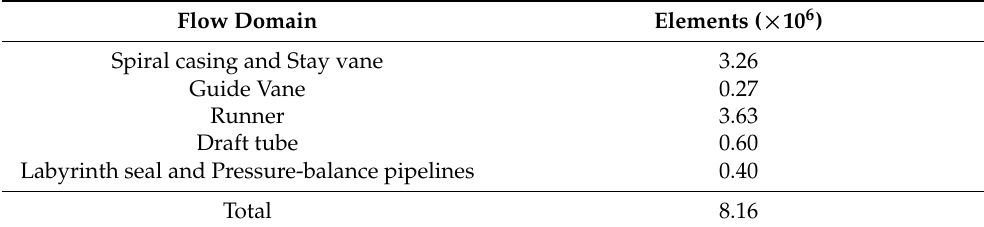
Figure 5. Mesh of the fluid domains. Table 1. Element number of flow